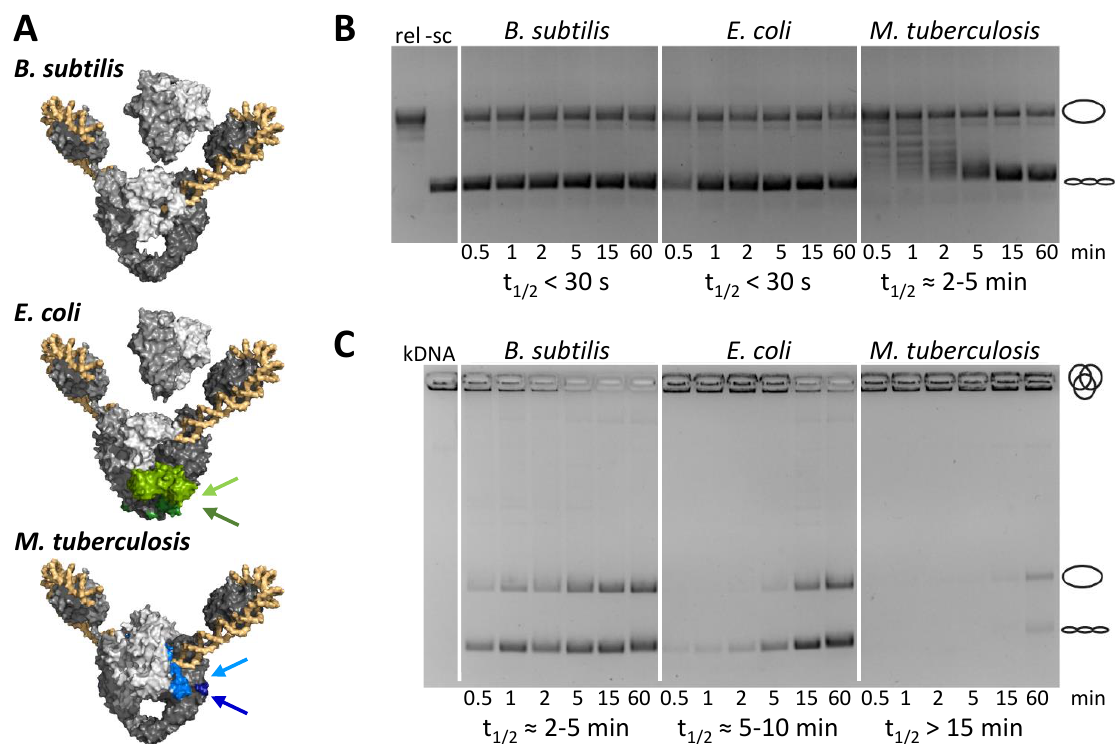
Figure 7. Species-specific elements in gyrase modulate enzymatic activities. ( A ) E. coli and M. tuberculosis gyrase contain insertion elements in GyrA and GyrB (depicted in light and dark green for E. coli , light and dark blue for M. tuberculosis , see arrows) that are absent in B. subtilis gyrase (top). These elements mediate additional interactions between the subunits. E. coli gyrase is shown in complex with ADPNP and the NBTI Gepotidacin, as observed by cryo-EM (PDB-ID 6rkw). The structure for B. subtilis gyrase is a homology model (see ref. [68] for details). The model of full-length M. tuberculosis gyrase represents the crystal structure of M. tuberculosis gyrase lacking the CTDs (PDB-ID 6gau), with the CTDs placed according to their position in the cryo-EM structure of E. coli gyrase. ( B ) The species-specific insertion elements modulate the supercoiling activity: B. subtilis and E. coli gyrase are efficient supercoiling enzymes that supercoil half of the DNA in less than 30 s. In contrast, M. tuberculosis gyrase catalyzes supercoiling more slowly, with a half-life of 2–5 min. The supercoiling endpoints also differ [74]. ( C ) The insertion elements also modulate the decatenation activity of the different gyrases. B. subtilis gyrase decatenates kinetoplastid DNA (kDNA) fastest with a half-life of 2–5 min; the half-life for E. coli gyrase is 5–10 min. M. tuberculosis gyrase is also the slowest enzyme in decatenation, with a half-life of >15 min. Figure modified from Weidlich and Klostermeier (2020). Functional interactions between gyrase subunits are optimized in a species-spe- cific manner. J. Biol. Chem. 295(8):2299–2312.